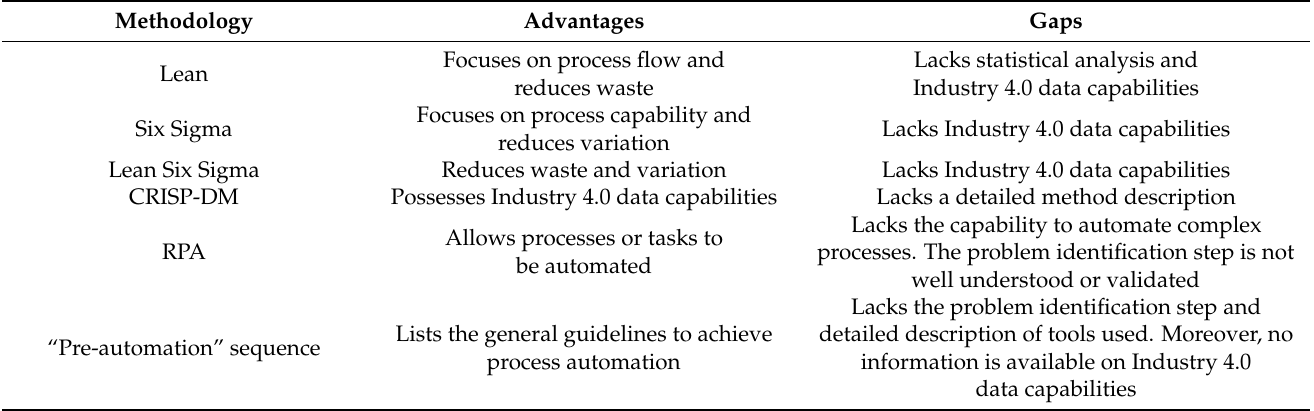
Table 2. Methodology